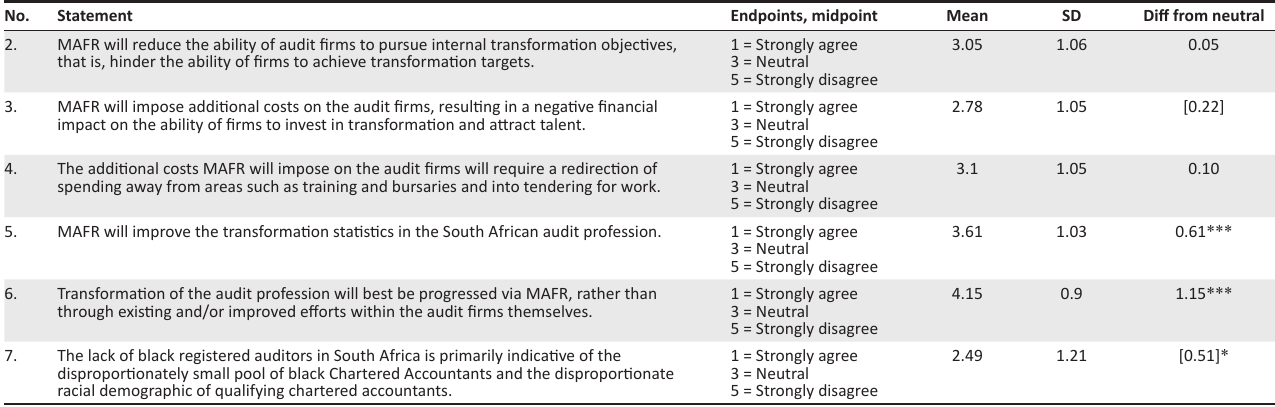
TABLE 4: Audit committee chairs’ perspectives on